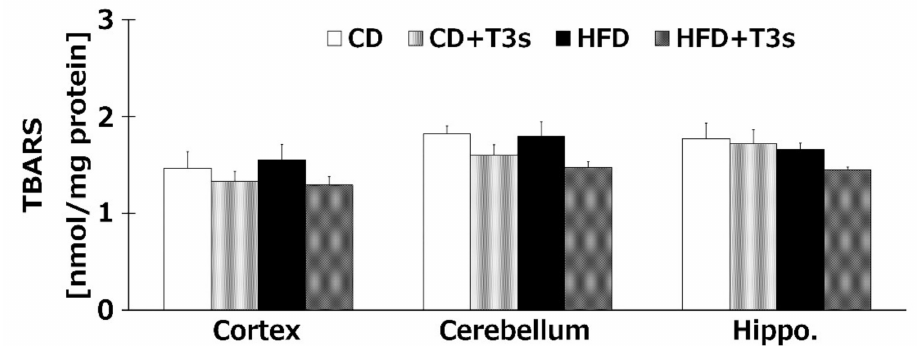
Figure6. Brainoxidationlevelsineachtreatmentgroup. CD = Controldiet( n = 10), CD + T3s = CD + T3 mix ( n = 10), HFD = high-fat diet ( n = 10), HFD + T3s = high-fat diet + T3 mix ( n = 10). Data are expressed as mean ± SE.